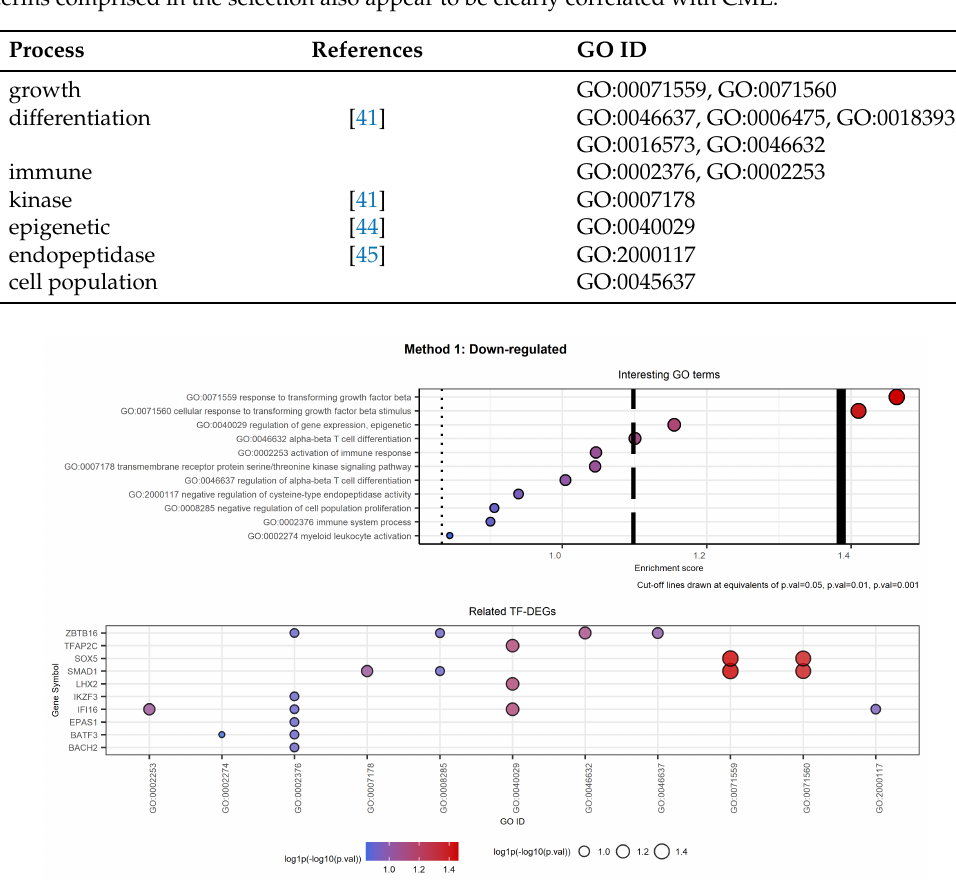
Figure 14. Selected GO terms and related TF-DEGs. The first plot shows selected GO terms on the y -axis and the respective log1p( − log10( p -value)) as the Enrichment score on the x -axis. The second plot shows TF-DEGs on the y -axis and the related GO terms on the x -axis. In both plots, colour and size of the bubbles depend on the Enrichment score. We note that genes SOX5 and SMAD1 are associated with the most significant GO labels, which results in being associated with cell